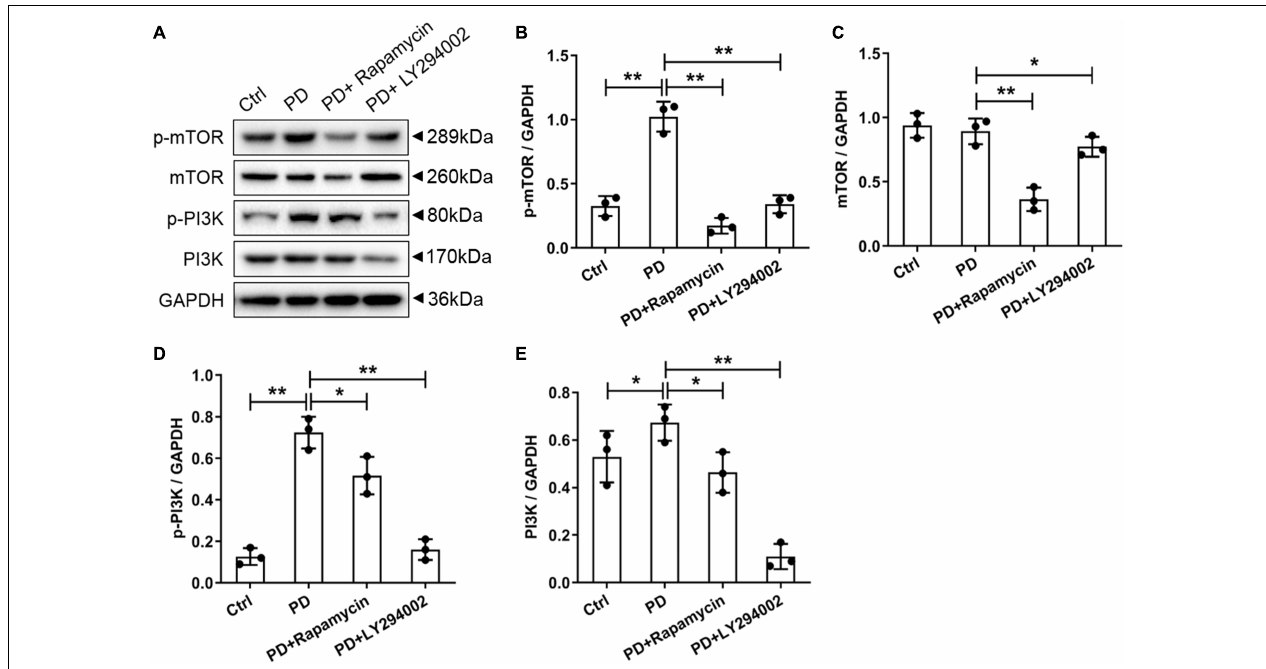
FIGURE 4 | Effects of LY294002 and rapamycin on PI3K/mTOR signalling pathway on HG-induced peritoneal fibrosis in rats. (A) The western blot results showed that levels of the p-mTOR, mTOR, p-PI3K and PI3K proteins changed in the PD rats and PD rats treated with LY294002 or rapamycin compared with those in